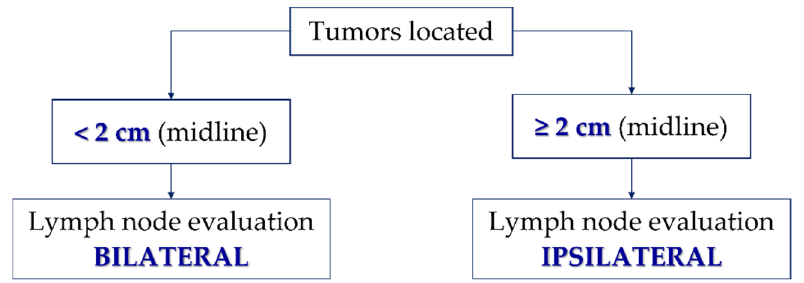
Figure 4. Flowchart of the evaluation of the lymph nodes about the location of the tumor about the midline.